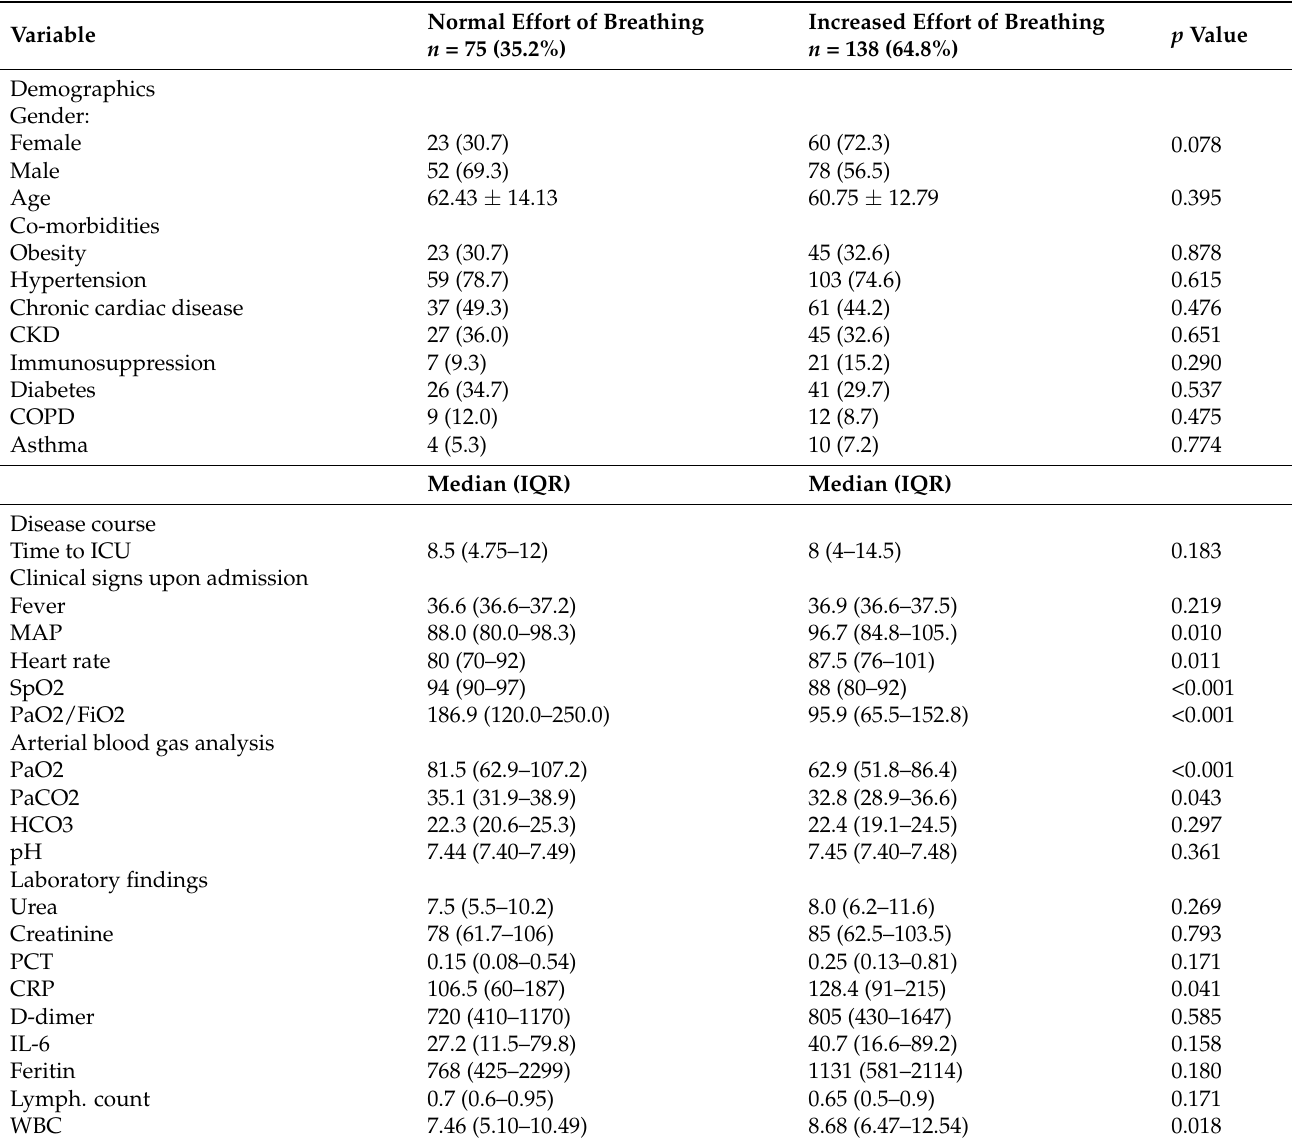
Table 3. Determinants of increased effort of